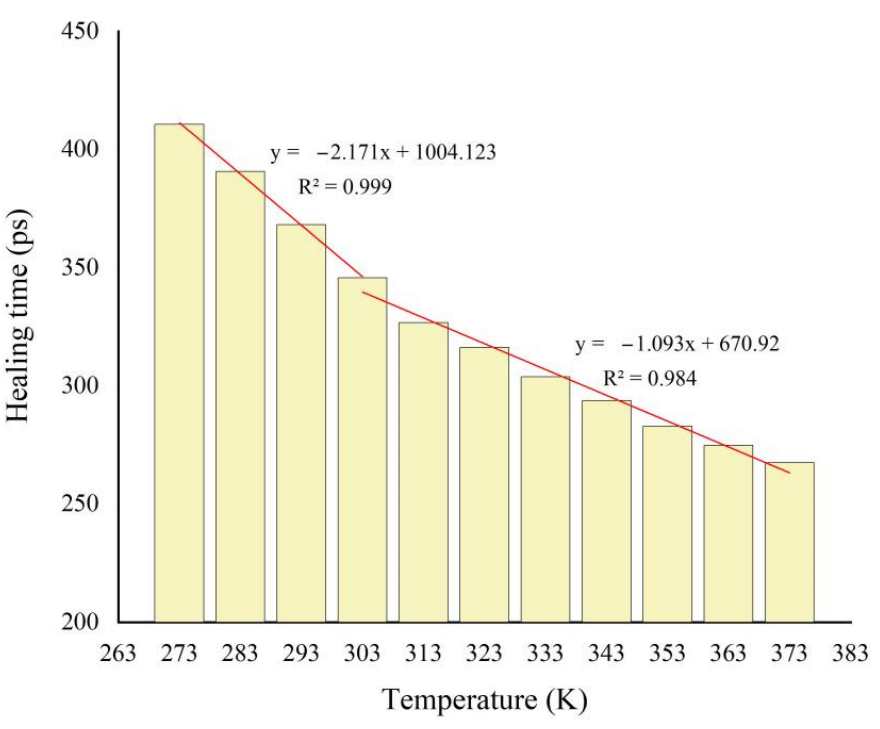
Figure 12. Healing time of microcrack model.